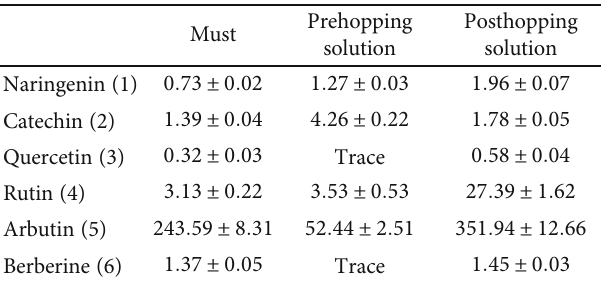
Figure 1: Structure of quanti fi ed compounds: (1) Naringenin, (2) Catechin, (3) Quercetin, (4) Rutin, (5) Arbutin, and (6) Berberine. Table 1: Values are expressed in ppm means from three independent samplings ± SD